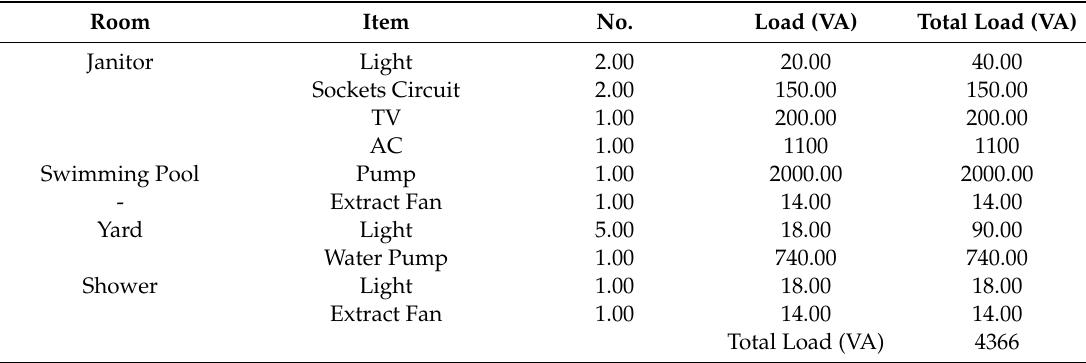
Table A4. List of the loads for the